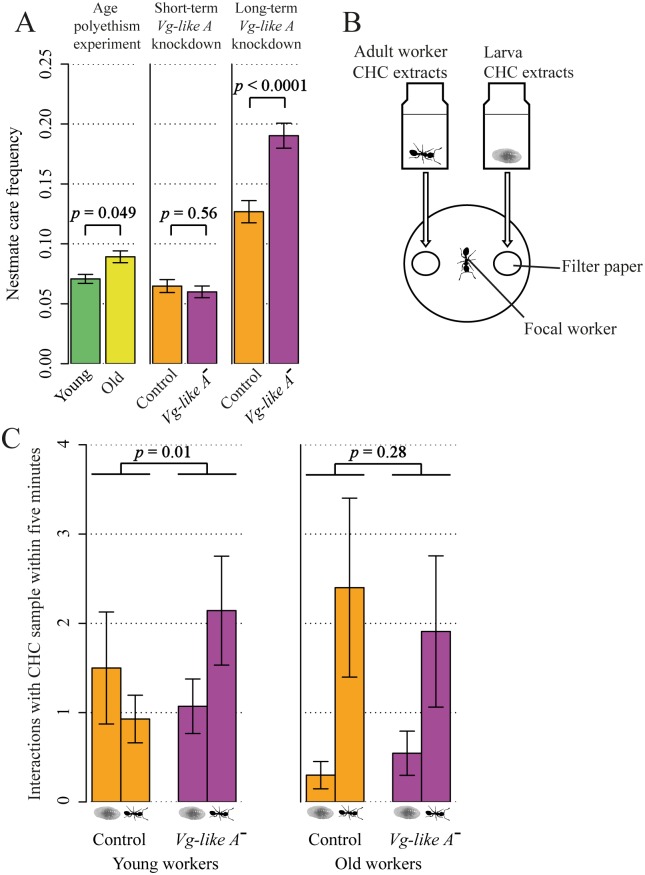
Long-term Vg-like A knockdown increases nestmate care behavior via alterations in cue responsiveness.(A) Under Vg-like A knockdown, young brood carers increased adult nestmate care, which we did not find under short-term knockdown. Nestmate care was usually taken over by the old workers. (B) Young (i.e., 3 months old) and old (i.e., 1 year or older) workers from control or Vg-like A− treatment were tested for preference for worker and brood CHC extracts. (C) In young workers, Vg-like A knockdown resulted in a change in cue responsiveness for brood and worker CHCs, whereas the knockdown did not affect old workers. In the control, young and old workers differed in the number of interactions with each extract (Binomial GLMM: p = 0.0003), whereas this was not the case under Vg-like A knockdown (Binomial GLMM: p = 0.32). CHC, cuticular hydrocarbon; GLMM, generalized linear mixed model; Vg, vitellogenin.